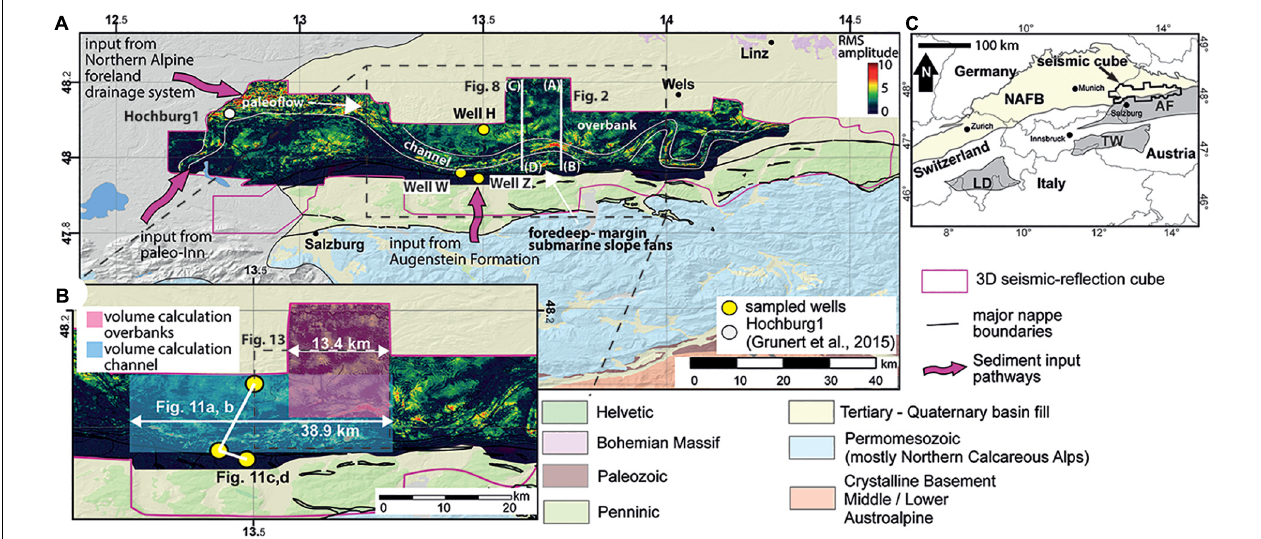
FIGURE 1 | (A) Simplified geological map of the Upper Austrian NAFB and position of the three analyzed wells and reference well Hochburg1 (Grunert et al., 2015). The pink outline shows the extent of the 3D-seismic cube provided by RAG. The inset shows a root mean square (RMS) amplitude map of the seismic-reflection surface of the Base Hall Unconformity outlining the axial channel, the extensive overbank deposits on the northern basin margin and the slope fans on the southern tectonically active margin. (B) Detail of (A) with location and extent of the volume calculation, the position of the three wells and the seismic cross sections between them. (C) Present location of the NAFB, the Lepontine Dome (LD), Tauern Window (TW), and 3D-seismic cube in central Europe. Additionally, the approximated position of the nowadays mostly eroded Augenstein Formation (AF) is